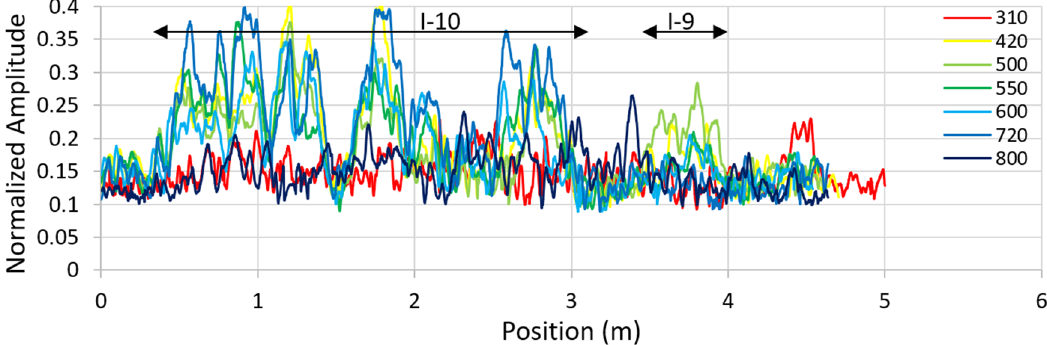
Remote Sens. 2021 , 13 , x FOR PEER REVIEW 23 of 34 Figure 37. 2.6 GHz Normalized RW amplitudes on defects I-9 and I-10, in the longitudinal direction vs. K loadings. Figure 37. 2.6 GHz Normalized RW amplitudes on defects I-9 and I-10, in the longitudinal direction vs. K loadings. Figure 37. 2.6 GHz Normalized RW amplitudes on defects I-9 and I-10, in the longitudinal direction vs. K loadings. Figure 37. 2.6 GHz Normalized RW amplitudes on defects I-9 and I-10, in the longitudinal direction vs. K loadings.